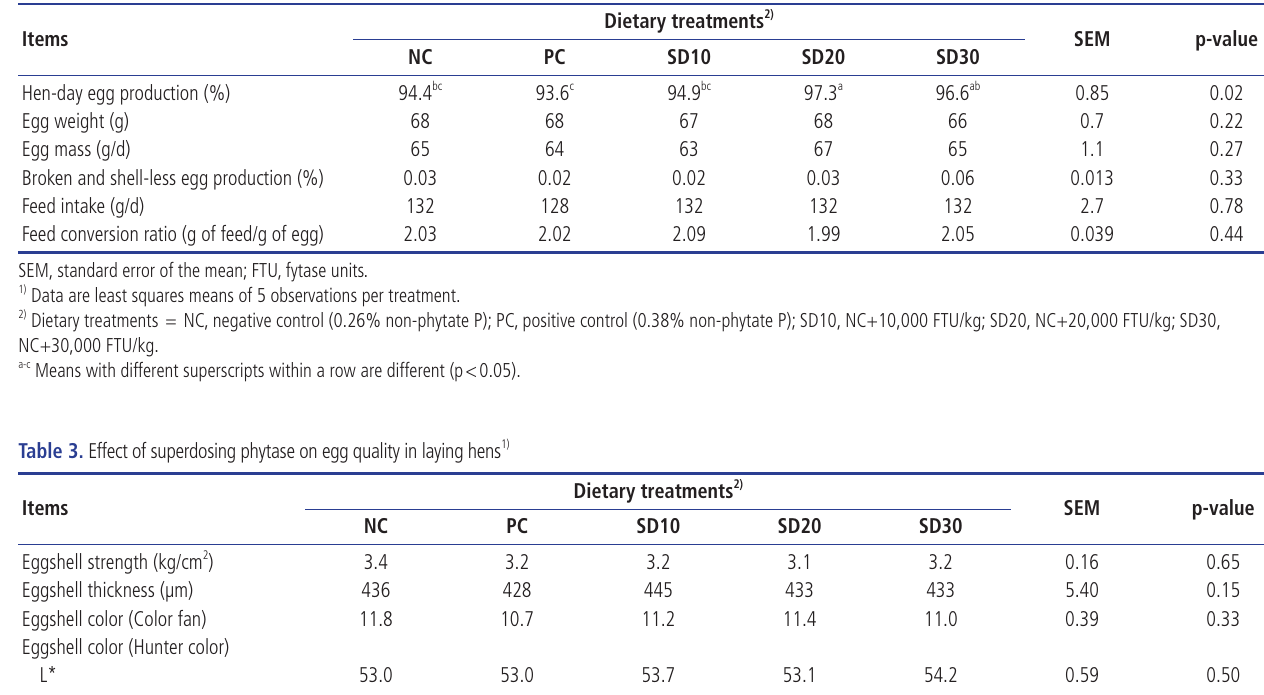
Table 2. Effect of superdosing phytase on productive performance in laying hens 1)